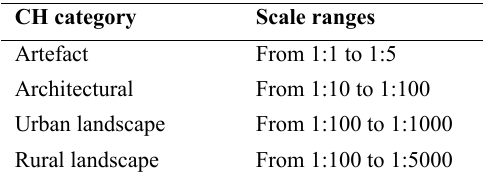
Table 1. Typical scale ranges for each of the CH categories commonly established (adapted from Kraak and Ormeling, 2011).